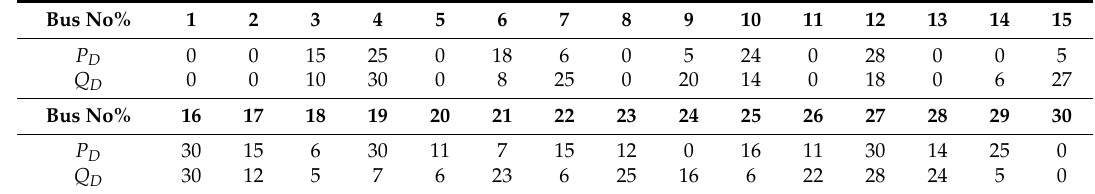
Table 13. ED simulation results compared with traditional ED and new loss coefficients of the IEEE 30-bus system under the nonconforming system demand change condition.